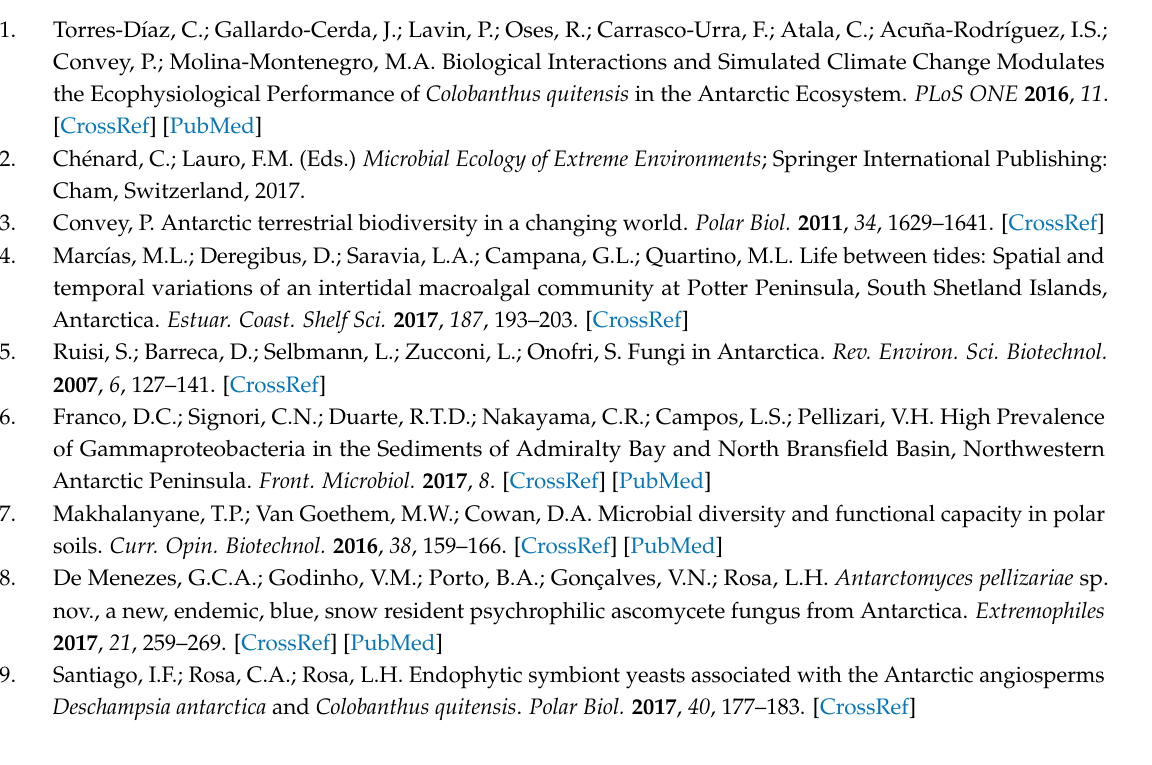
Figure S2: Estimates of Evolutionary Divergence between sequences from Deschampsia antarctica endophytic fungus ( Juncaceicola cf. typharum ) and other fungal sequences belonging to the Juncaceicola genus, following BLAST